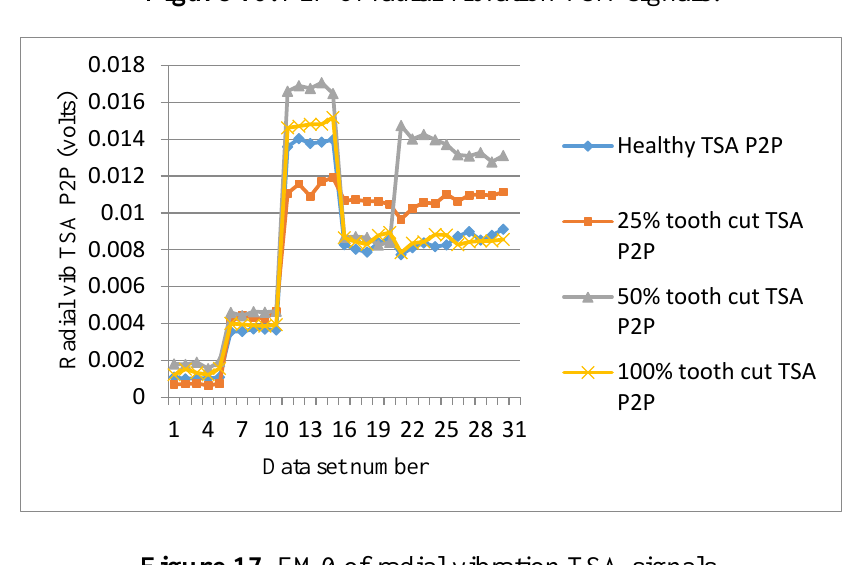
Figure 16. P2P of radial vibration TSA signals.